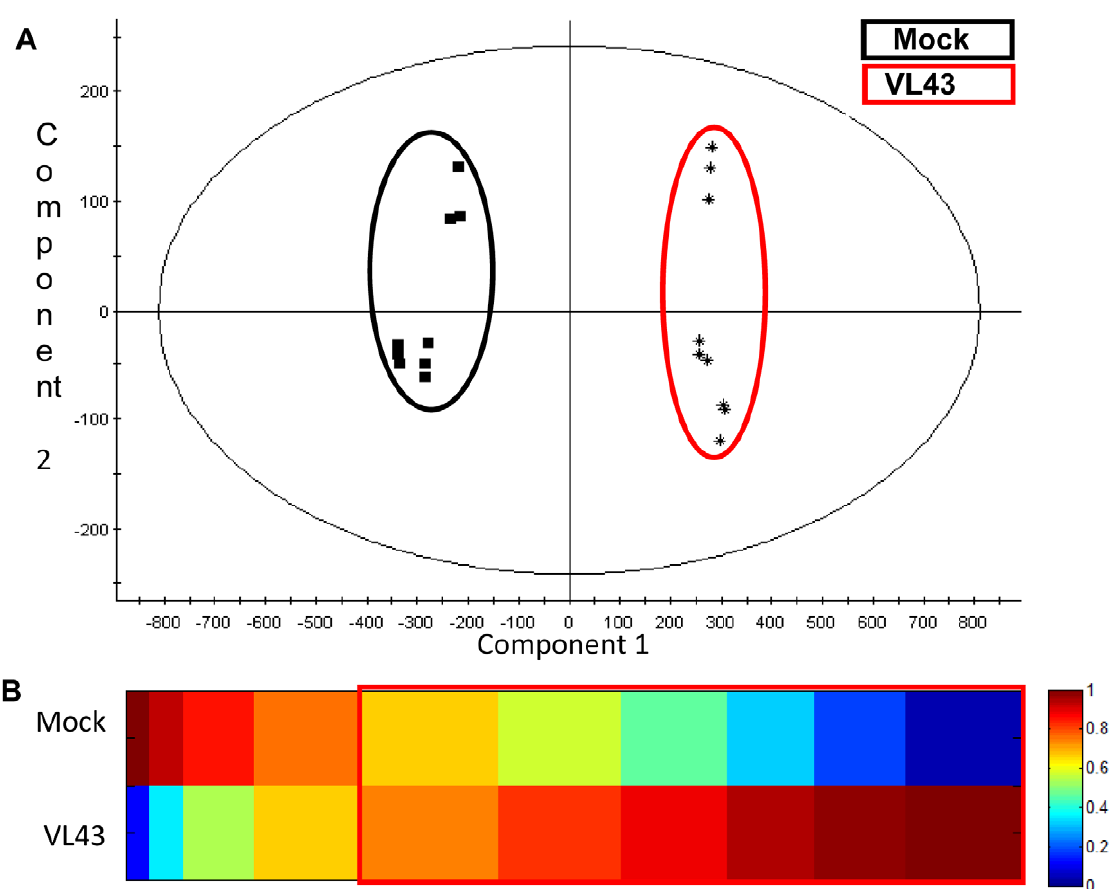
Figure 6. Metabolic fingerprinting of AWFs of mock- and Verticilliumlongisporum VL43-infected Arabidopsisthaliana plants. AWF was obtained from A. thaliana leaves 21 days post infection and analyzed by UPLC-TOF-MS. (A) PCA plot of compounds in extracted AWFs measured in negative ionization mode. Samples from mock treated plants are framed in black whereas samples from infected plants are framed in red. (B) 1D-SOM matrix after metabolite-based clustering of the 1775 infection markers with p , 5 6 10 2 4 . Data sets from positive and negative ionisation mode were combined. Red framed prototypes indicate markers with increased intensities after VL infection. The data set includes three biological replicates with three technical replicates per sample. The vertical axis represents the two experimental conditions. The horizontal axis corresponds to the cluster numbers. The intensities were normalized and colour coded according to the indicated scale.